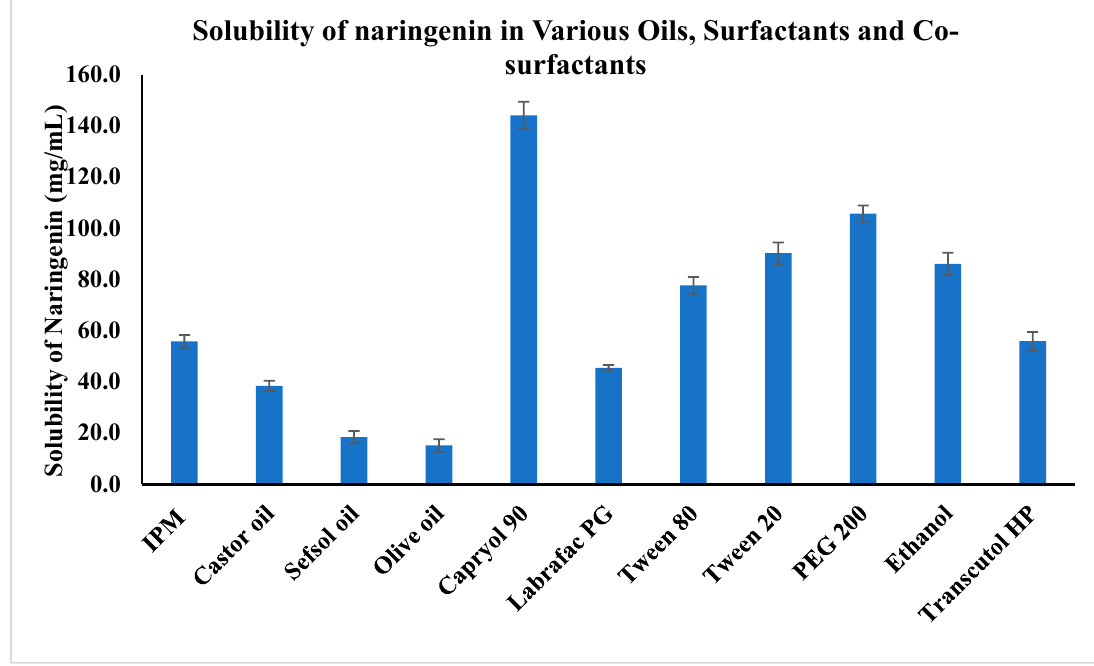
Figure 1. Solubility of naringenin in various oils, surfactants, and co-surfactants ( n = 3) ( p < 0.05; Capryol 90 vs. other oils, surfactants, and co-surfactants). Isopropyl myristate (IPM). Table 1. Independent variables with the coded values, the dependent variable, and the responses obtained for the various formulation